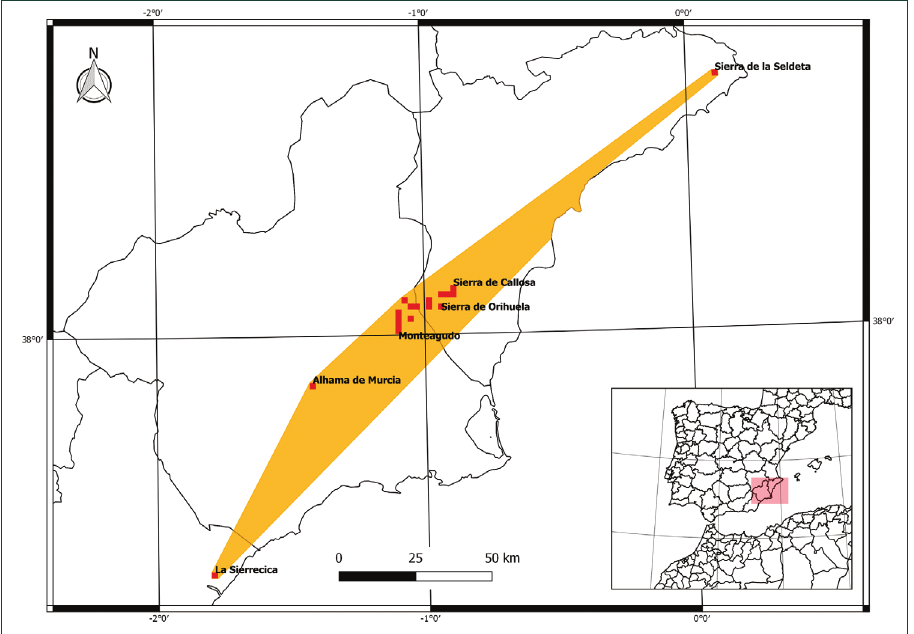
Figure 6. Extent of occurrence (orange) and area of occupancy (red) of Commicarpus plumbagineus in